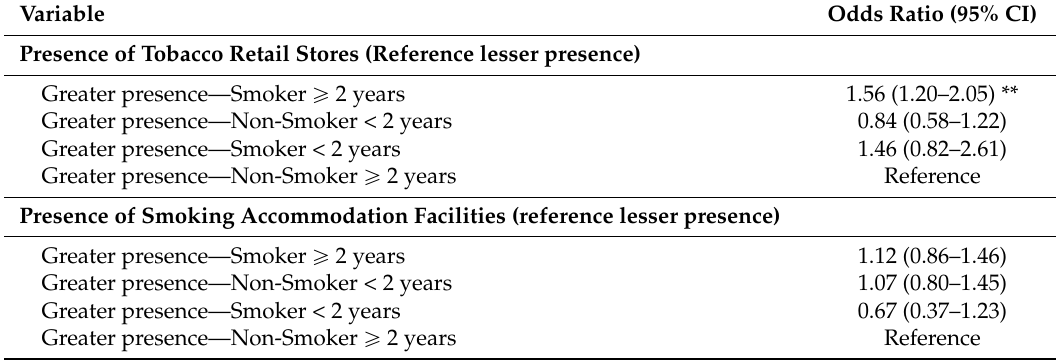
Table 3. Results of multinomial multilevel regression models predicting smoking trajectory over 2 years from SN-level exposures among 2070 adults living in Montreal, Canada in 2011–2012.